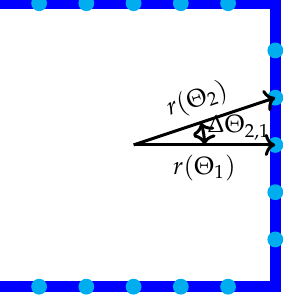
Figure 2. Visualization of the finite element method model with the electrode position in cyan and domain boundary in blue. r ( Θ 1 ) and r ( Θ 2 ) are the positional angles of the first and second electrodes. The angle difference ∆Θ 2,1 is needed for the calculation of the derivative in Equation